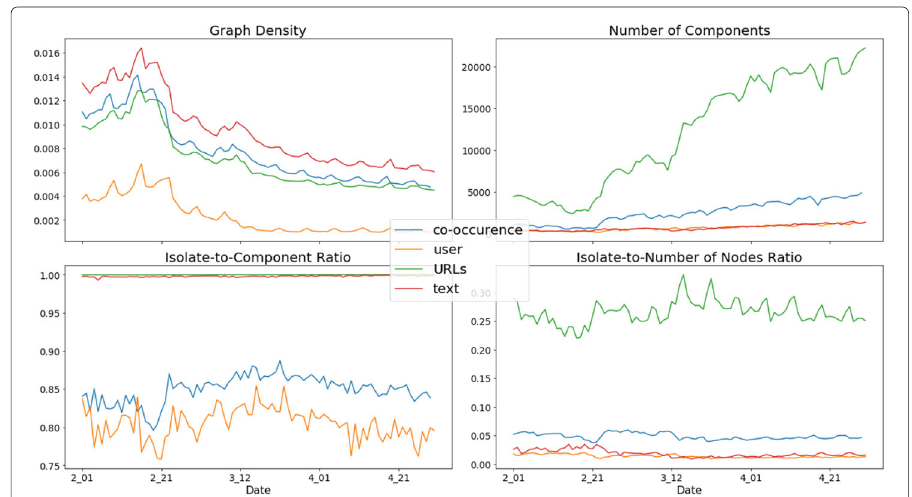
Fig. 4 Graph metrics for each of the daily view graphs. All views but the URL view display useful graph properties for clustering the